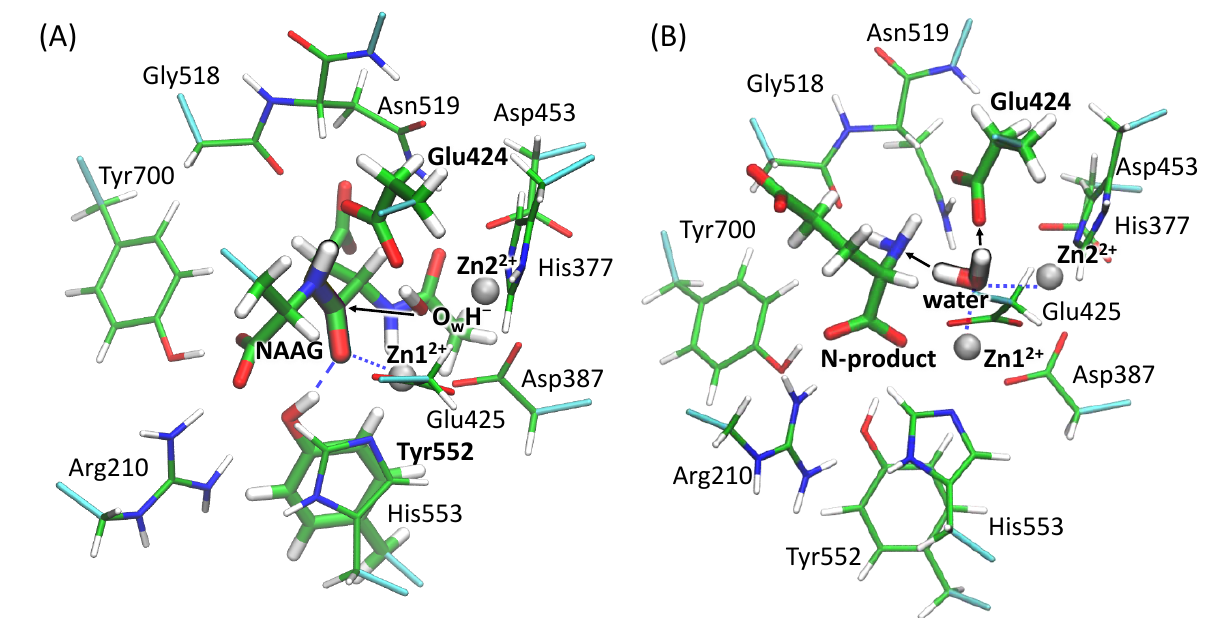
Figure 3. The active site of the wild type GCPII. ( A ) The QM subsystem utilized for the steps 1–4 in the Gibbs energy calculations. The catalytic residue Glu424, the residue Tyr552 that forms the “oxyanion hole”, a catalytic hydroxide anion and the substrate are shown in bold. The peptide fragment to be cleaved in the reaction is highlighted. ( B ) The QM subsystem utilized at the enzyme regeneration step. A water molecule that is responsible for the enzyme regeneration as well as the N-product and Glu424 are highlighted. Color code: zinc—grey, oxygen—red, sulfur—yellow, nitrogen—blue, hydrogen—white, carbon—green. Cyan covalent bonds depict borders between the QM and MM region. Blue dashed and dotted lines are used for the hydrogen and coordination bonds, respectively. Black arrows show the direction of the nucleophilic attack in panel (A) and possible proton transfer directions in panel (B).